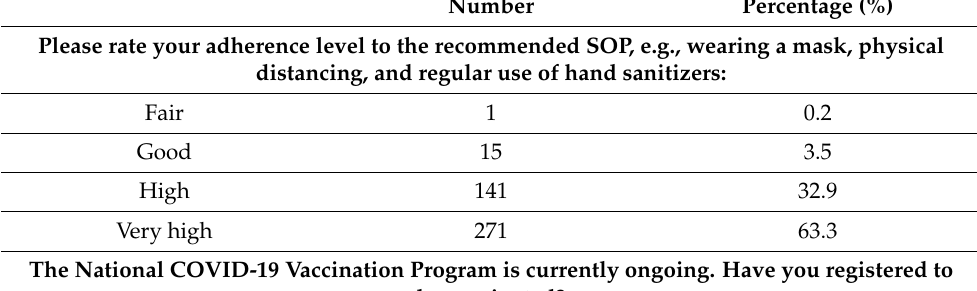
Table 2. Preventive measures and vaccination attitudes among study participants. Number Percentage